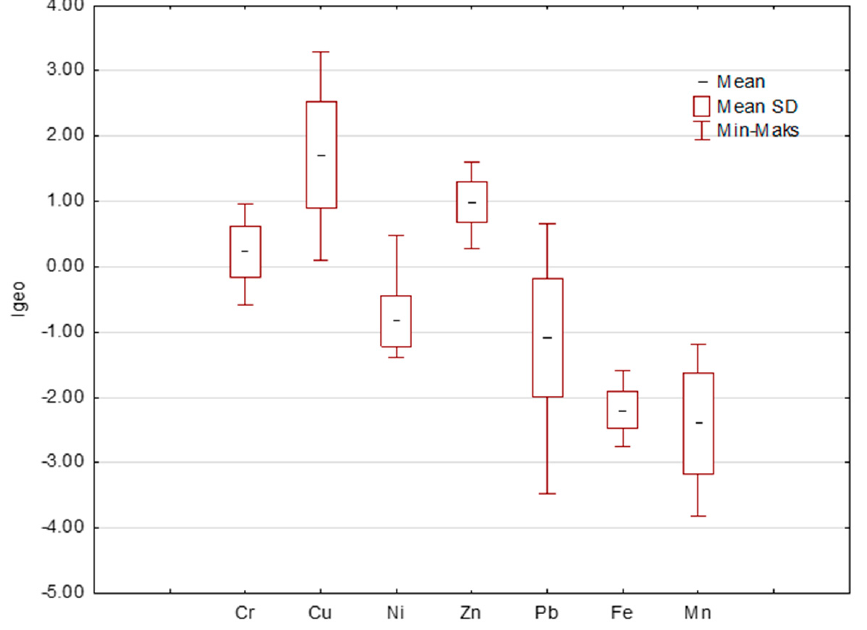
Figure 2. Assessment of level of pollution by Igeo. An enrichment factor (EF) can be used to assess metal contamination of road dust and the likely contribution of anthropogenic sources [36,53,54]. Slightly different results were obtained by analyzing the values of the EF index than the Igeo values. The values of this index for Fe and Mn allowed us to classify the studied dusts as minimal enrichment. The average EF values for Ni and Pb ranged from 2 to 5, which means moderate enrichment of dusts in these elements. Significant enrichment was shown by Cu, Zn, and Cr for which the EF values ranged up to 5 to 20 which suggests significant enrichment having an eminently anthropogenic origin. Figure 3 shows the EF values.